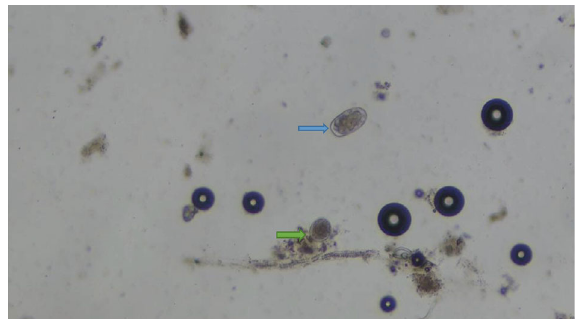
Figure 5: Strongyle -egg types (arrows green) and Strongyloides ransomi (blue